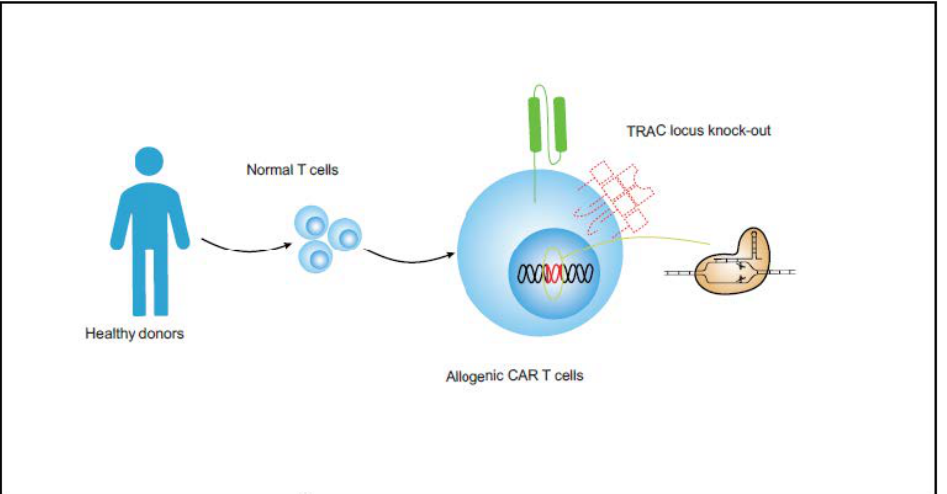
Figure 5. Preparation process of allogeneic CAR T cells from healthy donors. Independent antigenic presentation by MHC molecules for recognition makes γδ T